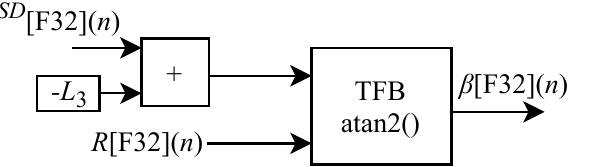
Figure 15. Proposed circuit to perform the calculation of β [ F 32 ]( n ) (Equation (22))—IK-HSD. The value of α [ F 32 ]( n ) is obtained from the circuit shown in Figure 16 which is based on Equation (23) and is designed to work with an input signal r [ F 32 ]( n ) and one output signal. The circuit is composed of five multipliers, two adders, one inverter, one divider, one TFB sub-circuit to perform the arccosine calculation and the constants L 1 and L 2 .